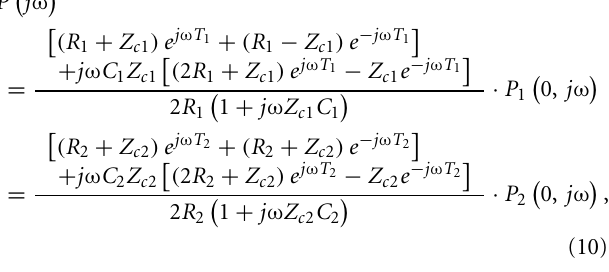
of increasingunderestimationof pulsetransittimewithdecreasing heart